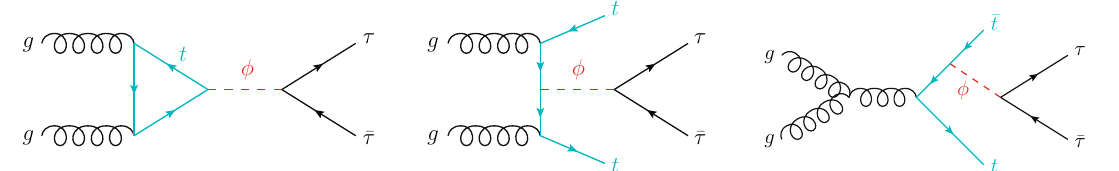
Fig. 1 RepresentativeFeynmandiagrams foranarrow resonance φ exchange inthegluonfusion( gg → τ ¯ τ )andthetop-quark associatedprocesses ( gg → t ¯ t + τ ¯ τ